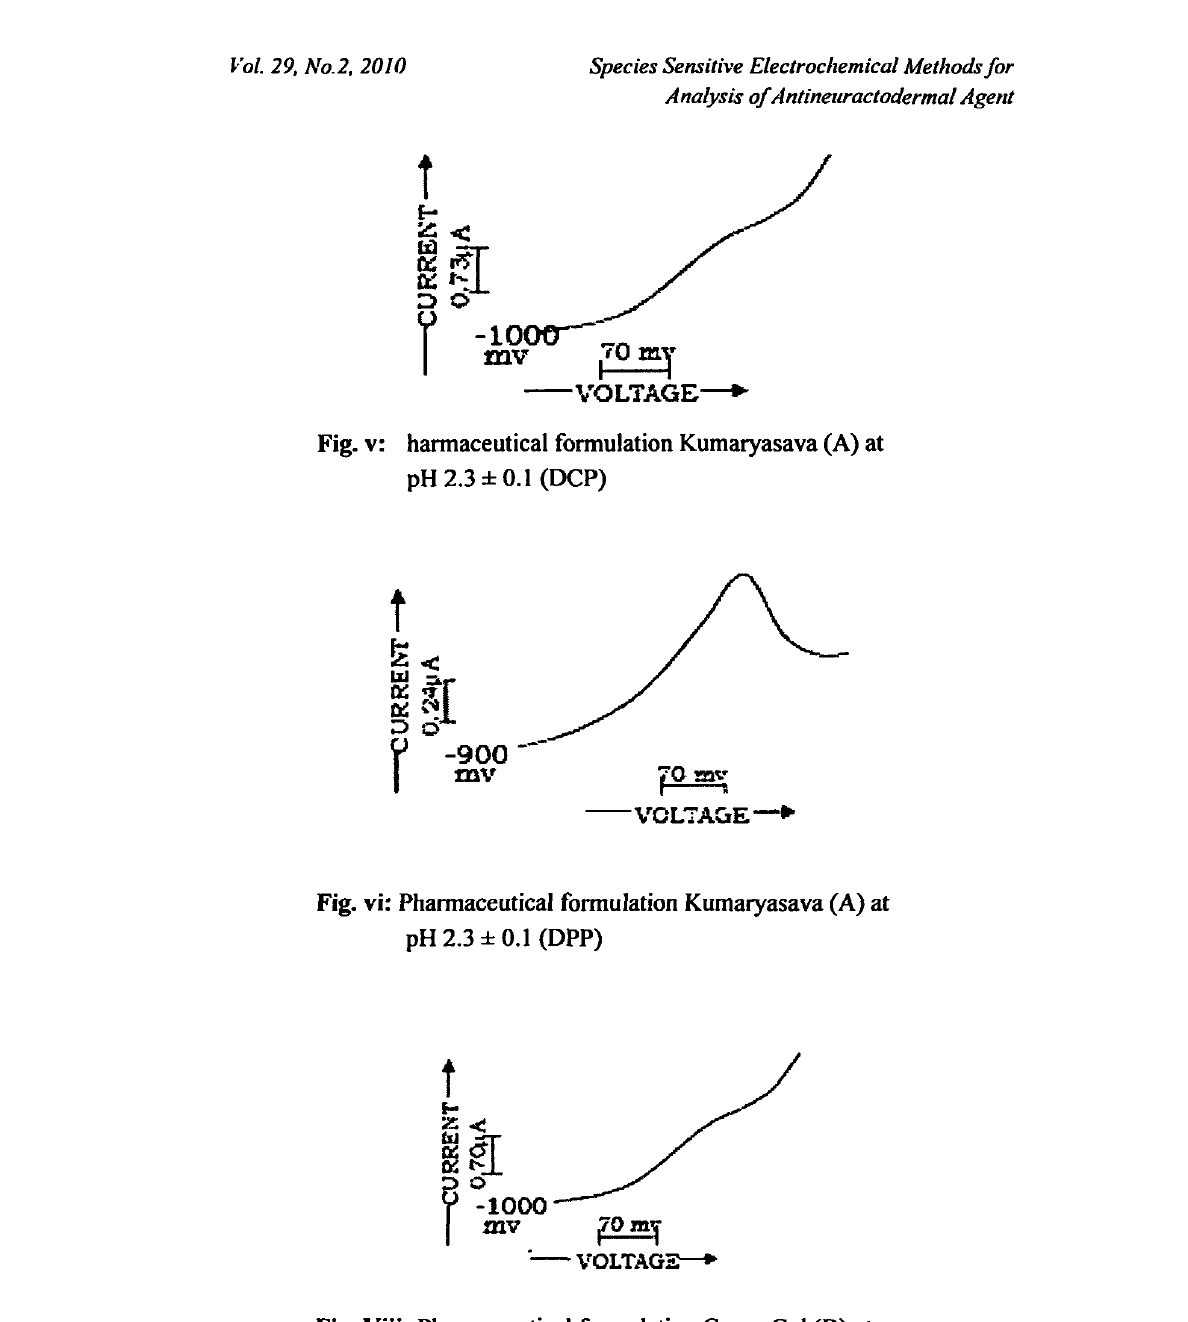
Fig. Viii: Pharmaceutical formulation Green Gel (B) at